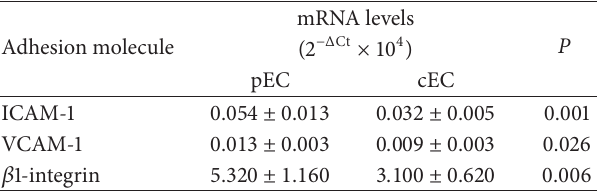
Table 4: Comparison between adhesion molecules mRNA levels in pEC and cEC at visit 2. Values are expressed as mean ± standard error